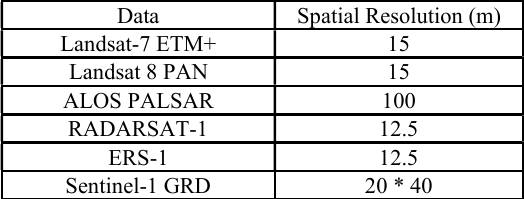
Table 1. The specifications of the dataset used in this study